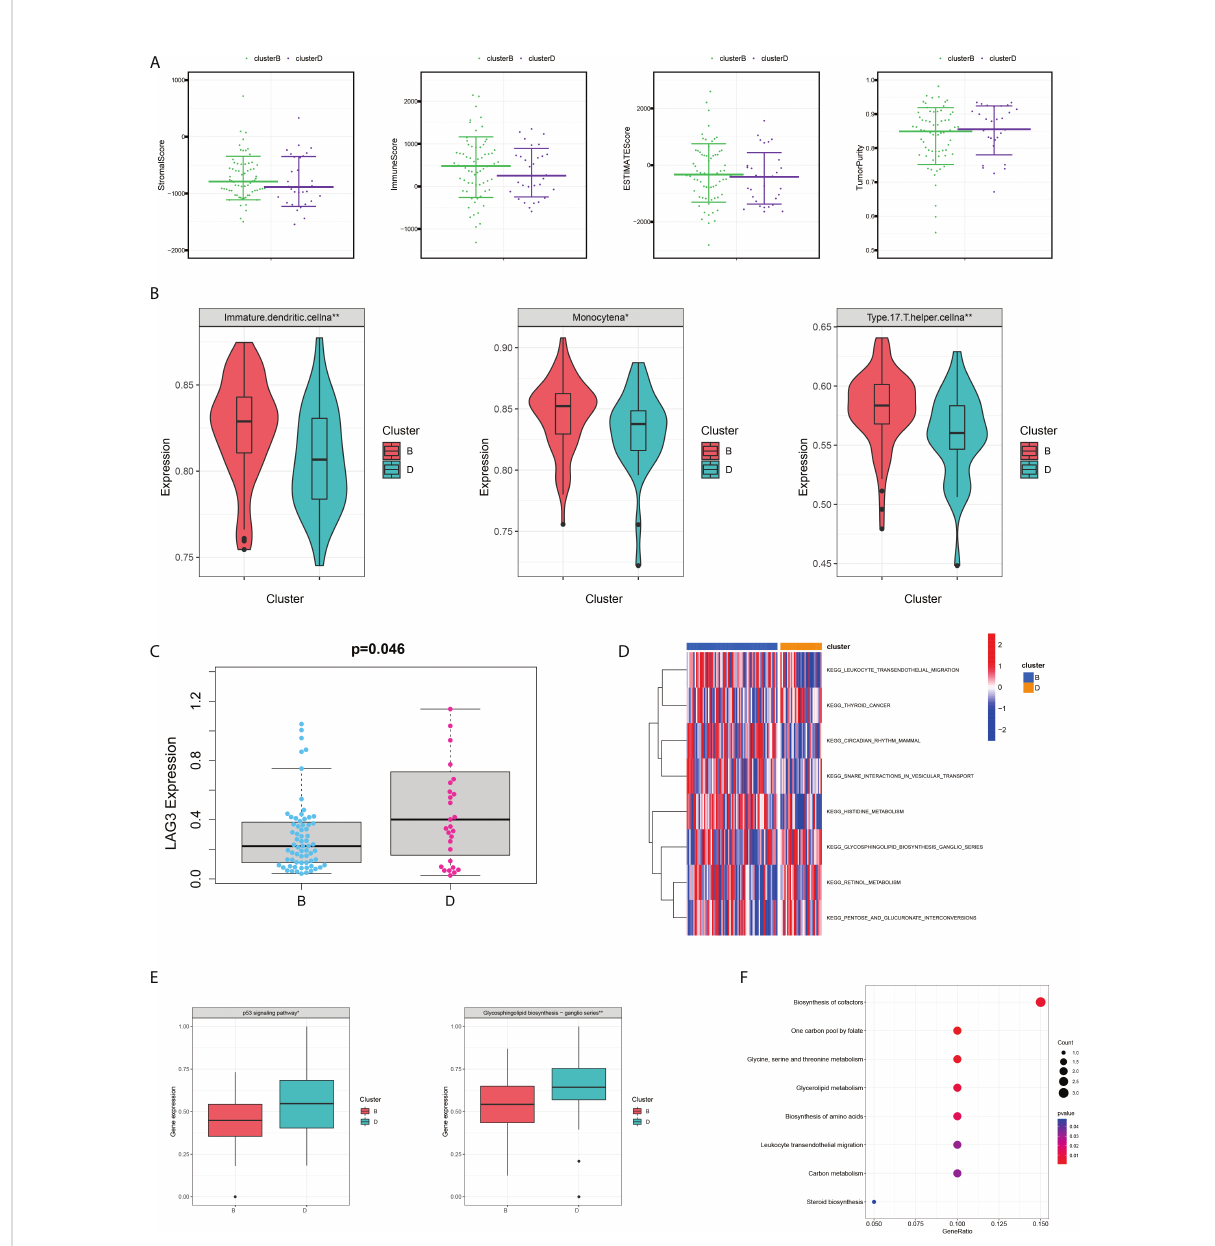
FIGURE 3 Variations of TME immune-related characteristics and metabolic molecular patterns between cluster B and D. (A) Samples in cluster B demonstrated higher stromal, immune, and ESTIMATE scores and lower tumour purity than those in cluster D. (B) The abundance of the main immune-in fi ltrating cells in TME in the two serine metabolic patterns. Cluster D was classi fi ed as the immunosuppressive phenotype, characterised by immune suppression. (C) Differences in the expression of LAG3, one common immune checkpoint, between clusters B and D (P = 0.046). (D) GSVA enrichment analysis revealed the activation level of biological pathways in distinct serine metabolic modi fi cation patterns. The heatmap was utilised for visualisation, in which red represents activated pathways and blue represents inhibited pathways. (E) Differences in tumour-related pathways including the p53 signalling pathway and glycosphingolipid biosynthesis pathway between the two serine metabolic patterns; *p < 0.05, **p < 0.01, and ***p < 0.001. (F) KEGG pathway enrichment of differentially expressed genes between clusters B and D. The improved items were analysed using gene counts, gene ratio, and adjusted